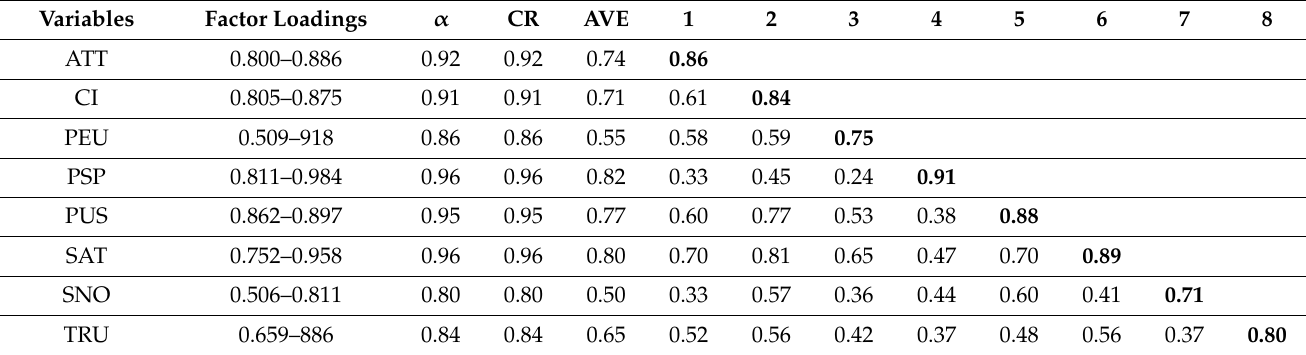
Table 2. Results of validity and reliability of measurement model (n =